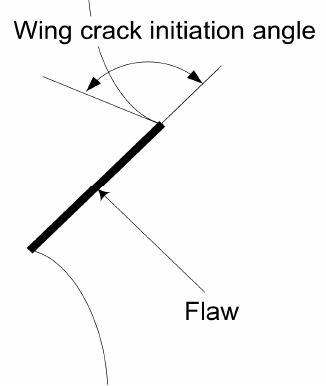
Figure 10. Wing crack propagation angle measurement.